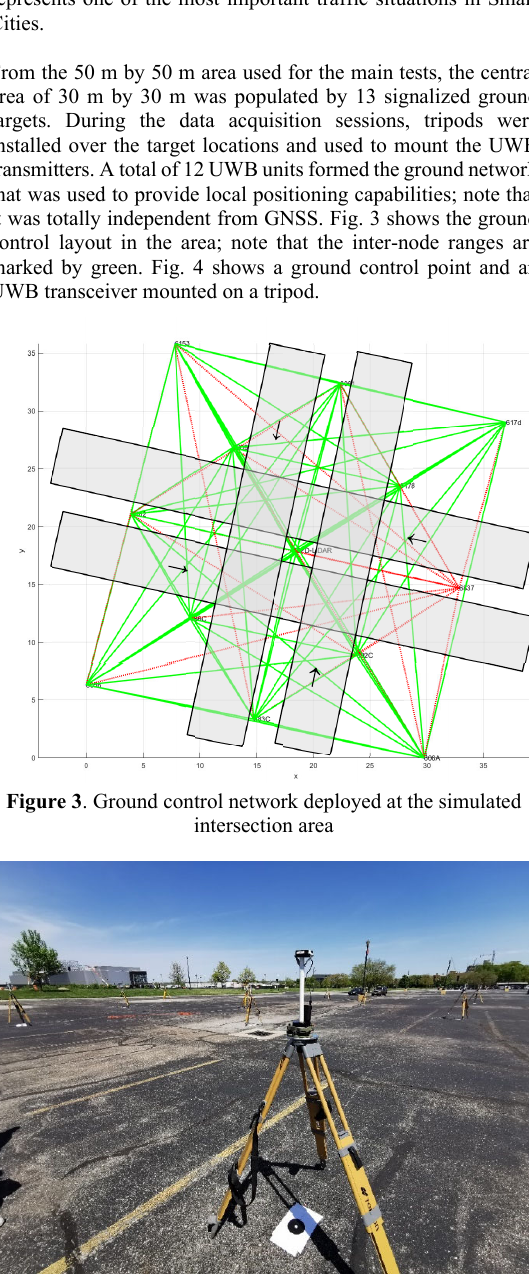
Figure 4 . Ground target to support image-based georeferencing and UWB transceiver installed on tripod area